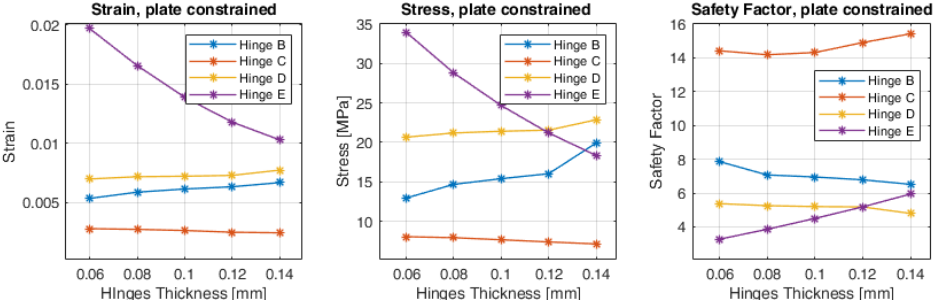
Figure 8. Results of the FEM modal analyses conducted by varying thickness of the flexure hinges, with the output plate constrained and 1 N loading force. For each flexure hinge, the graphs show computed strain, stress, and safety factor respectively.